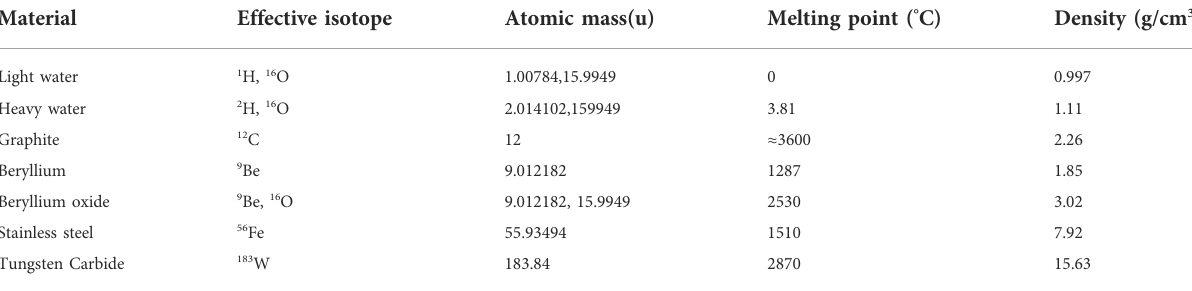
TABLE 1 Material properties of potentially available re fl ector materials.